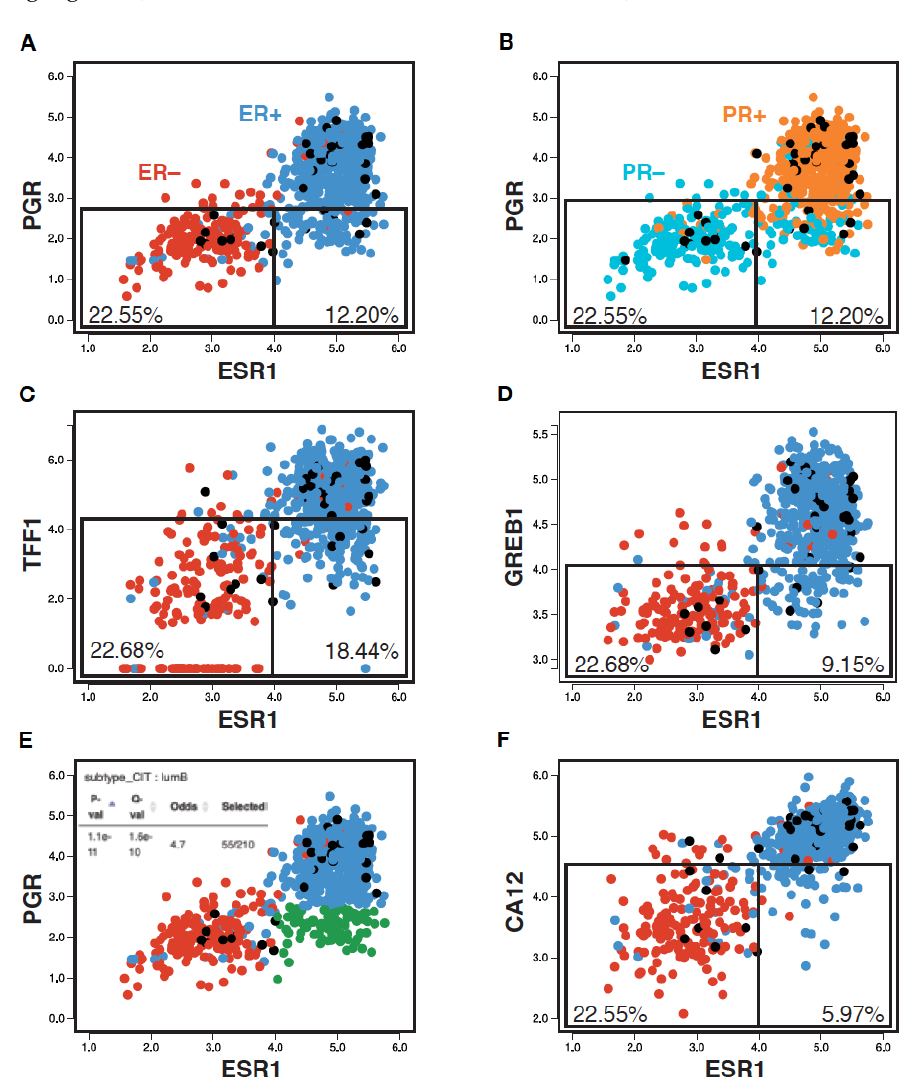
Figure 1. PR status imperfectly reflects ESR1 expression, ER status and activity. Pair-wise scatterplots for the expression of ESR1 vs PGR ( A , B , E ), TFF1 ( C ), GREB1 ( D ) and CA12 ( F ) generated using MiSTIC [55]. Boxes identify 90% of ESR1 low tumors, and the portion of ESR1 high tumors identified using the same threshold of positivity for different ER target genes. Percentages of total tumors are shown. Enrichment of ESR1 high PGR low tumors (highlighted in green) in the CIT luminal B tumor subtype is shown in the inset of panel ( E ).